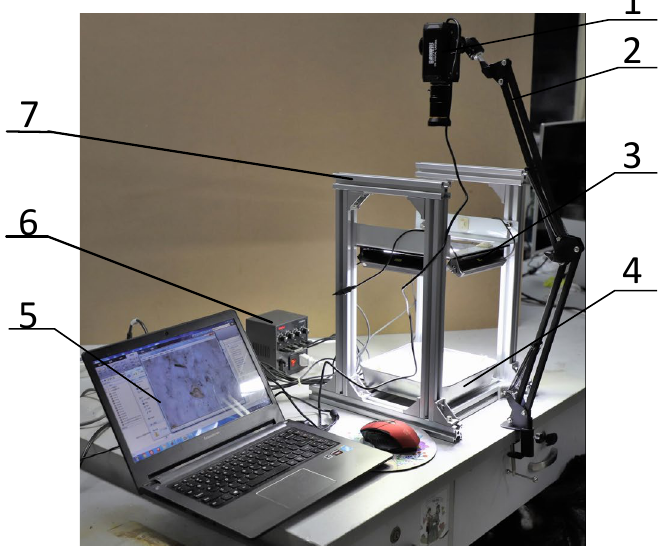
Figure 1. Picture of the image acquisition test bed. 1. Camera; 2. Camera holder; 3. Light source; 4. Cotton box; 5. Computer; 6. Light source controller; 7. Brace.